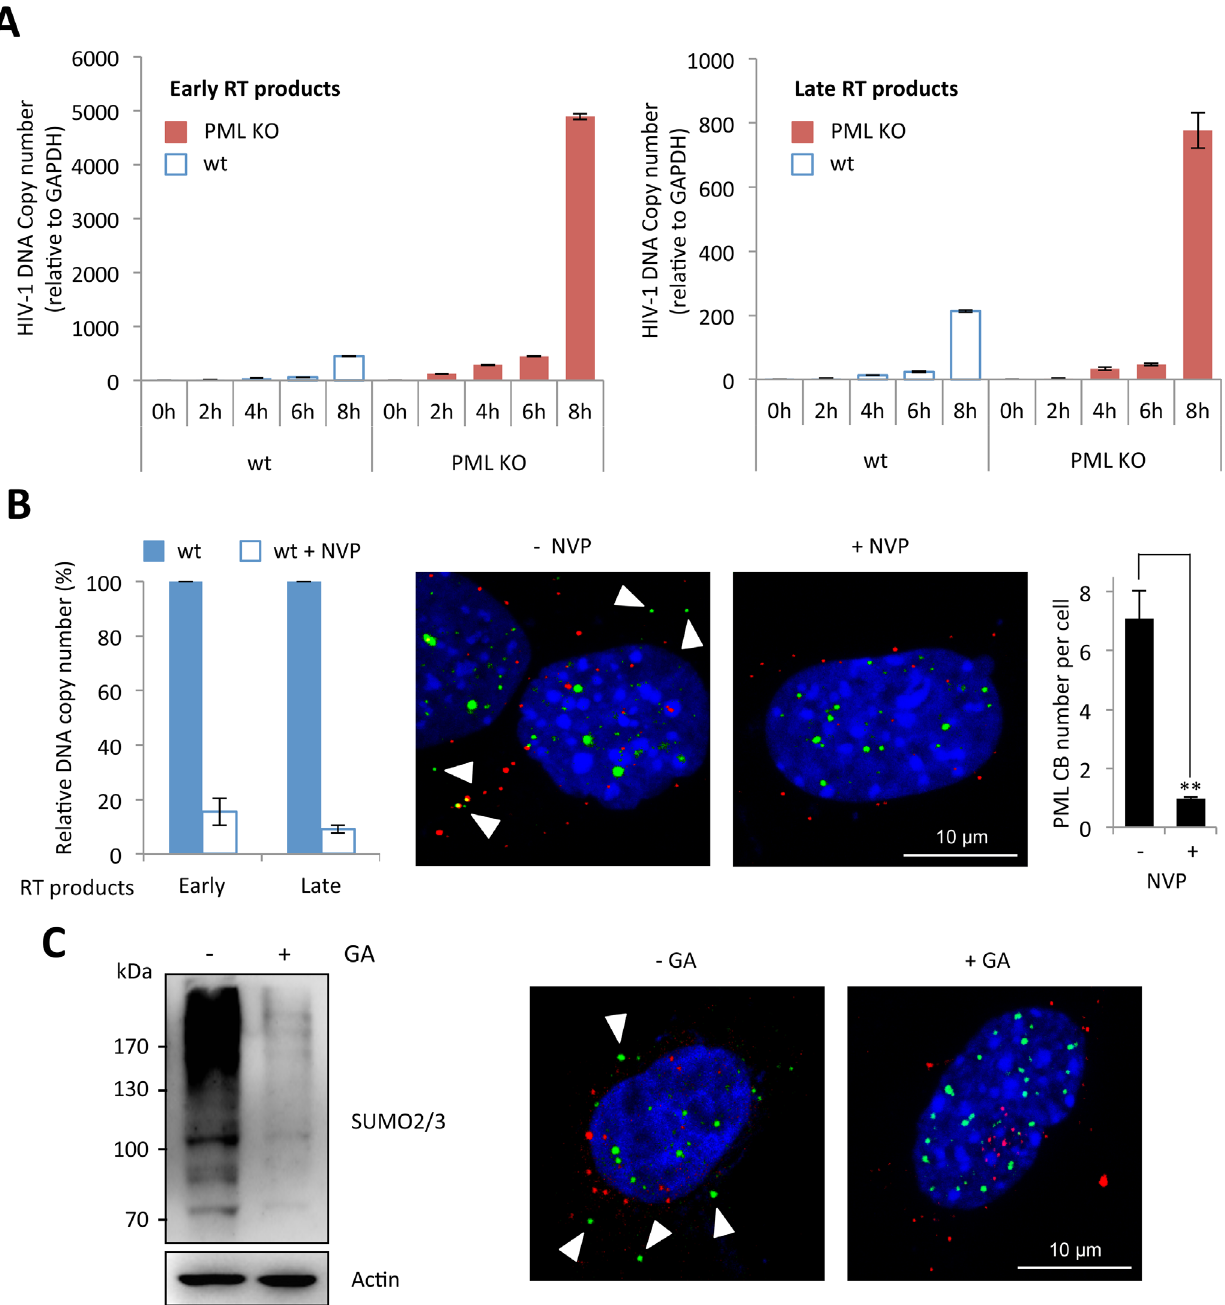
Fig 3. Reverse-transcription is the step affected by PML expression and the required event triggering PML CB formation. (A) Wt or PML KO MEFs were transduced for different times at MOI 10 with VSV-G pseudotyped HIV-1 derived vector, DNA was extracted and early and late reverse transcript were quantified by qPCR. (B) Wt or PML KO MEFs were treated for 30 min with nevirapine (NVP) before a 2 h transduction at MOI 10 with HIV-1 vector. DNA was extracted and early and late RT products were quantified by qPCR (left panel). PML (in green) and p24 (in red) localization was determined by immunofluorescence (middle panel). For each condition, the number of PML CBs was quantified in 50 cells from 3 independent fields (right panel). Student t- test was performed to determine P values ( ** P < 0.01). (C) The amount of SUMOylated proteins in wt MEFs treated with GA for 24 h was evaluated by western-blot (left panel). In parallel, wt MEFs pretreated with GA for 4 h were transduced for 2 h at MOI 10 with HIV-1 vector and PML (in green) and HIV-1 p24 (in red) localization was determined by immunofluorescence (right panel).